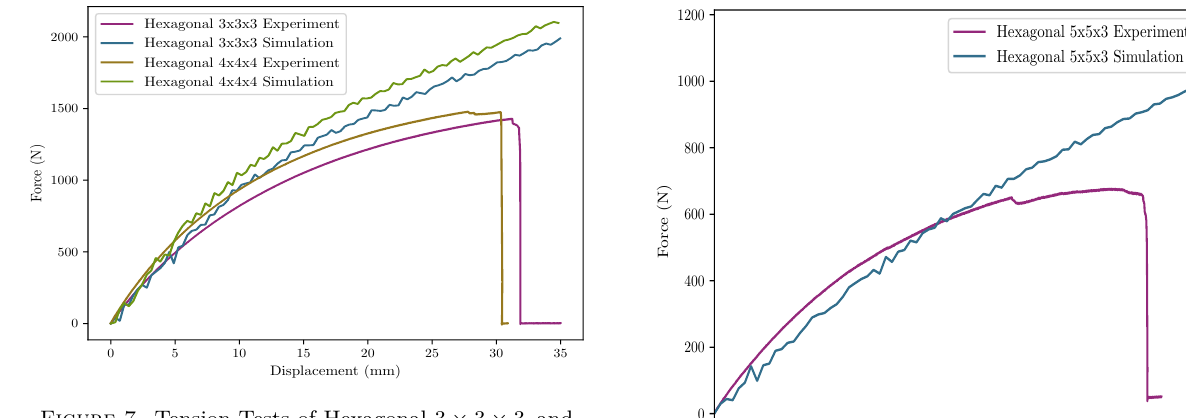
Figure 7. Tension Tests of Hexagonal 3 × 3 × 3 and Hexagonal 4 × 4 × 4